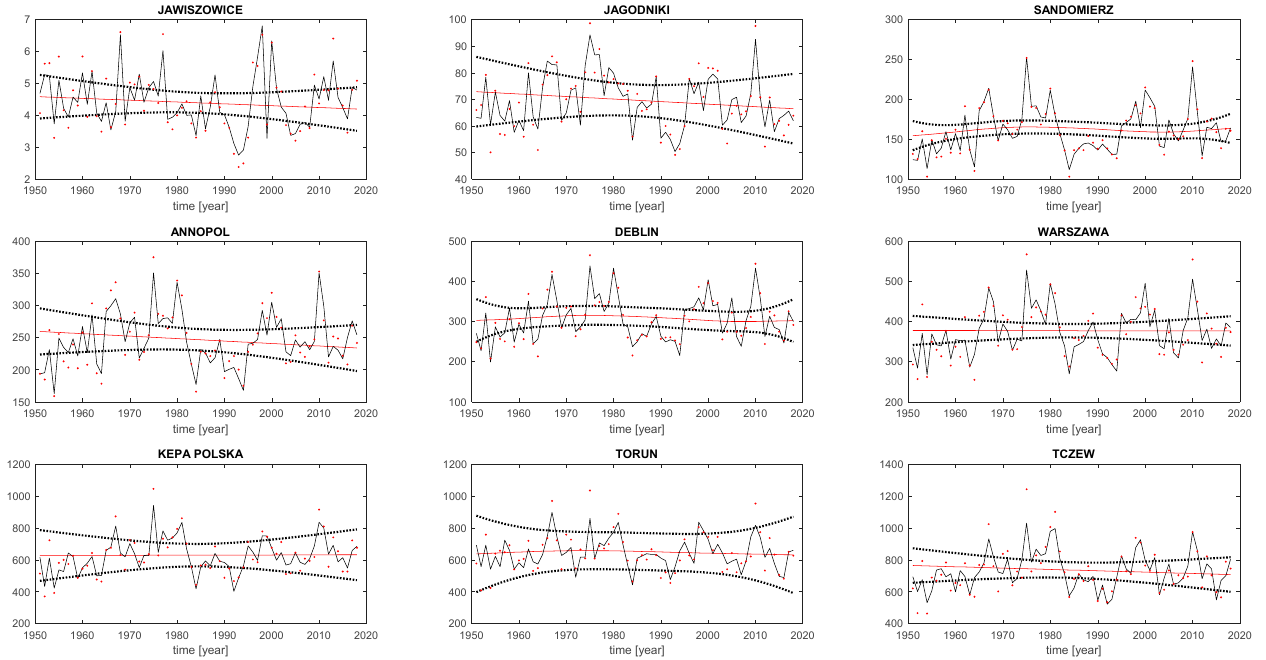
Figure 6. Time-series analysis of minimum annual flows at nine gauging stations along the Vistula River using the DHR model. Red dots denote annual minimum flow values (m 3 /s), black solid lines denote DHR model estimates, red solid lines denote estimated trends, and black dotted lines denote 0.95 confidence limits of trend estimates.